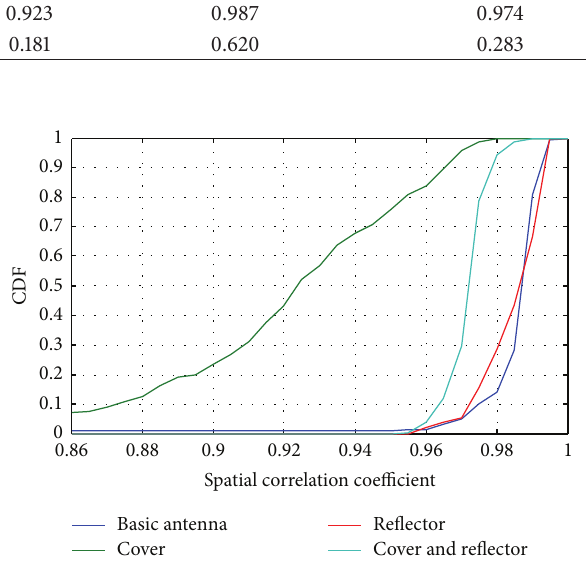
Figure15:Scatterplotforspatialcorrelationcoefficientinfourtypes of